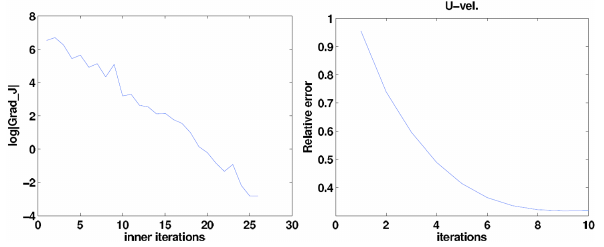
Figure 5. Figure shows the gradient of the cost function after each inner iteration (left) and the reduction of the relative error for zonal velocity for the DBFN experiment (right).